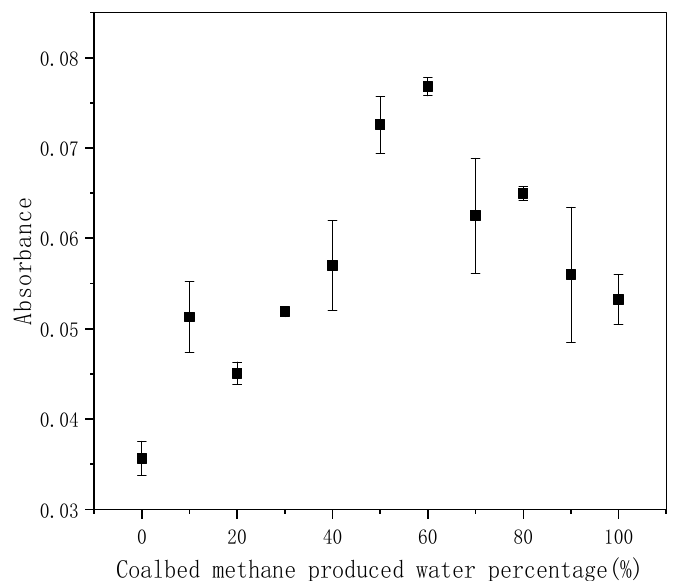
Figure 7. The 24 h-cultivation-effect of CBM produced water of different concentration on bacterial growth (the greater the absorbance value, the greater the density of bacteria in the culture solution, and the length of the error bar represents the uncertainty of the data).